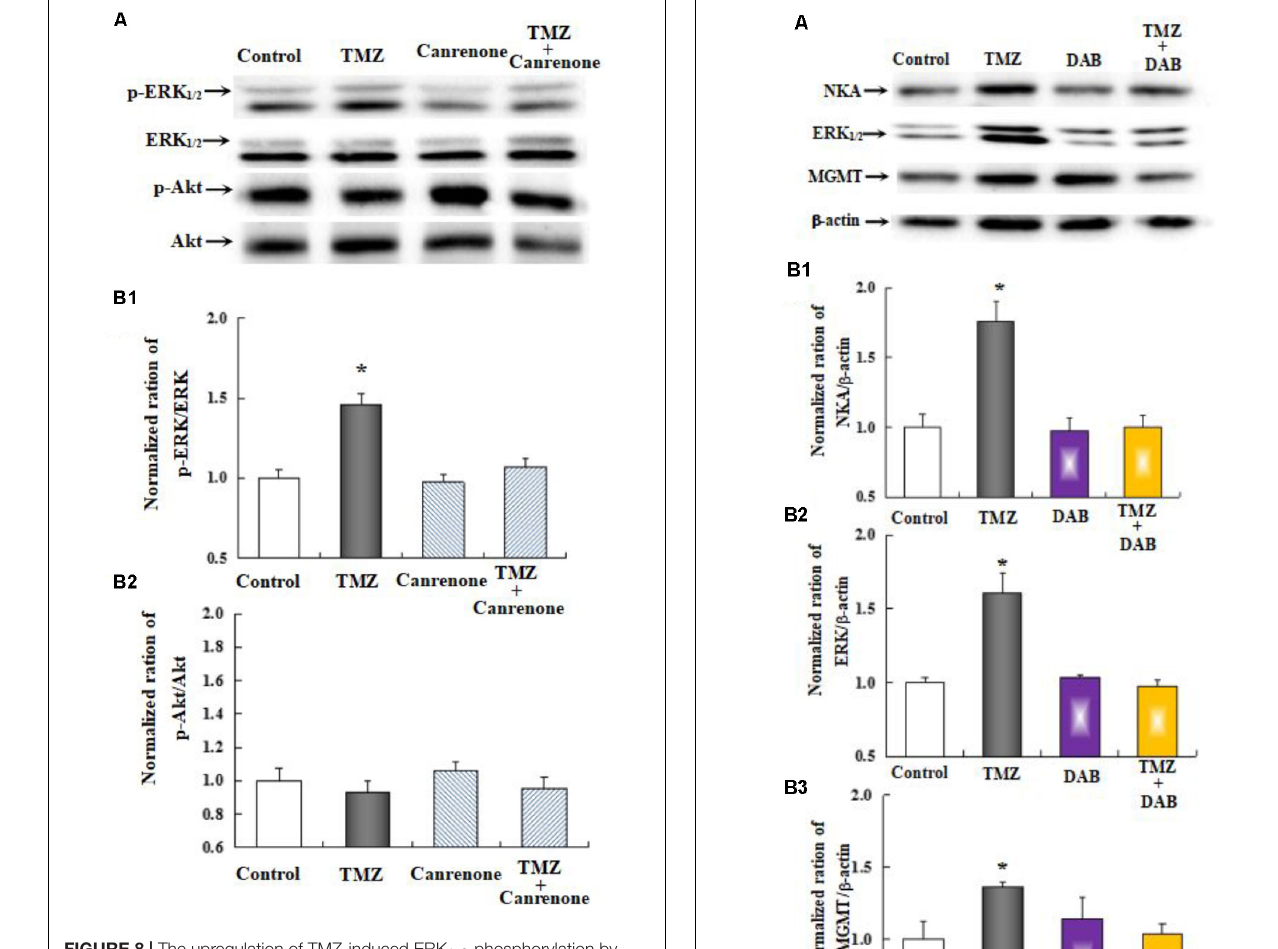
FIGURE 8 | The upregulation of TMZ-induced ERK 1 / 2 phosphorylation by Na,K-ATPase in U251 cells. (A) Cells were incubated for 20 min in the absence of any drug (Control) or in the presence of 5 µ M TMZ. In some experiments, 10 µ M Canrenone, an inhibitor of Na,K-ATPase, was added ( Figure 6 ). (B1) Mean ERK phosphorylation was quantified as ratios between p-ERK 1 / 2 and ERK 1 / 2 . (B2) Mean Akt phosphorylation was quantified as ratios between p-Akt and Akt. Similar results were obtained from three independent experiments. SEM values are indicated by vertical bars. ∗ Indicates a statistically significant ( P < 0.05) difference from the negative control group.